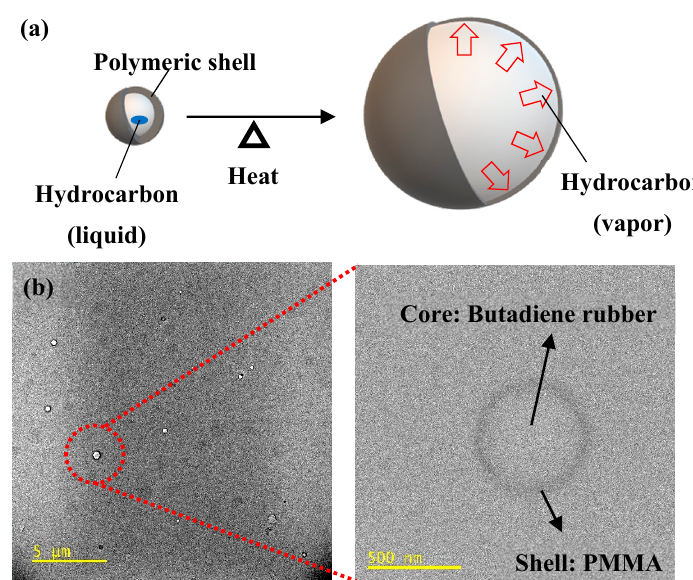
Figure 1. ( a ) Foaming mechanism of expandable microcell foaming agent and ( b ) TEM images of core–shell rubber (CSR) particle.